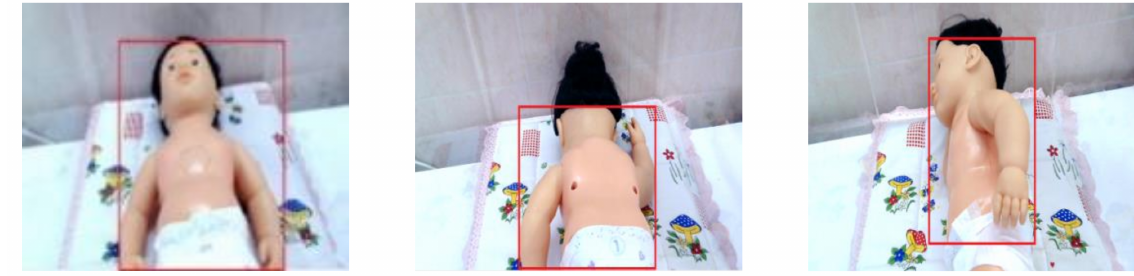
Figure 4. The region of interest in different